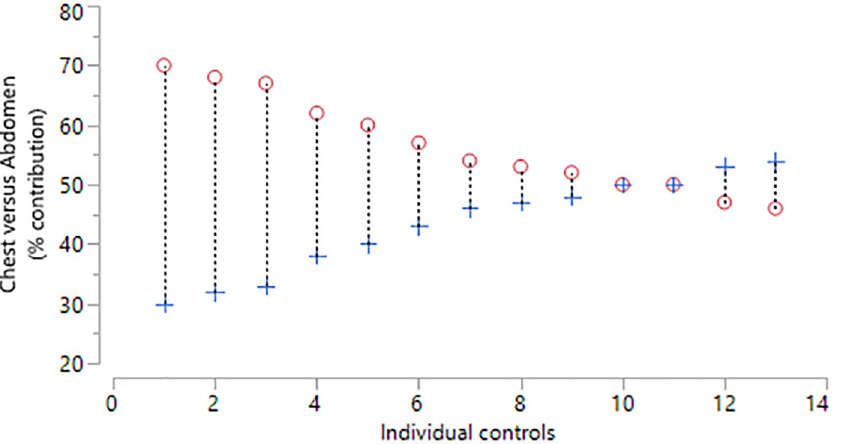
Fig 8. Percentage rib cage and abdominal wall contribution to total TA displacement for controls (n = 13) during one minute of tidal breathing. Circle = Rib cage contribution, Cross = Abdominal wall contribution.